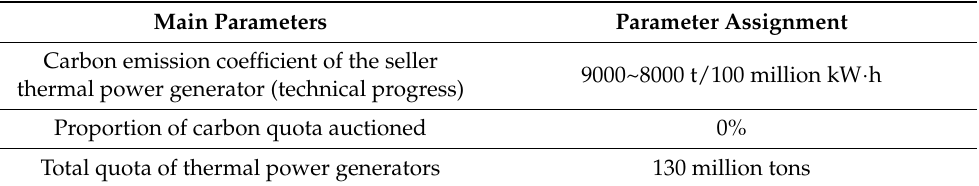
Table 1. Basic scenario